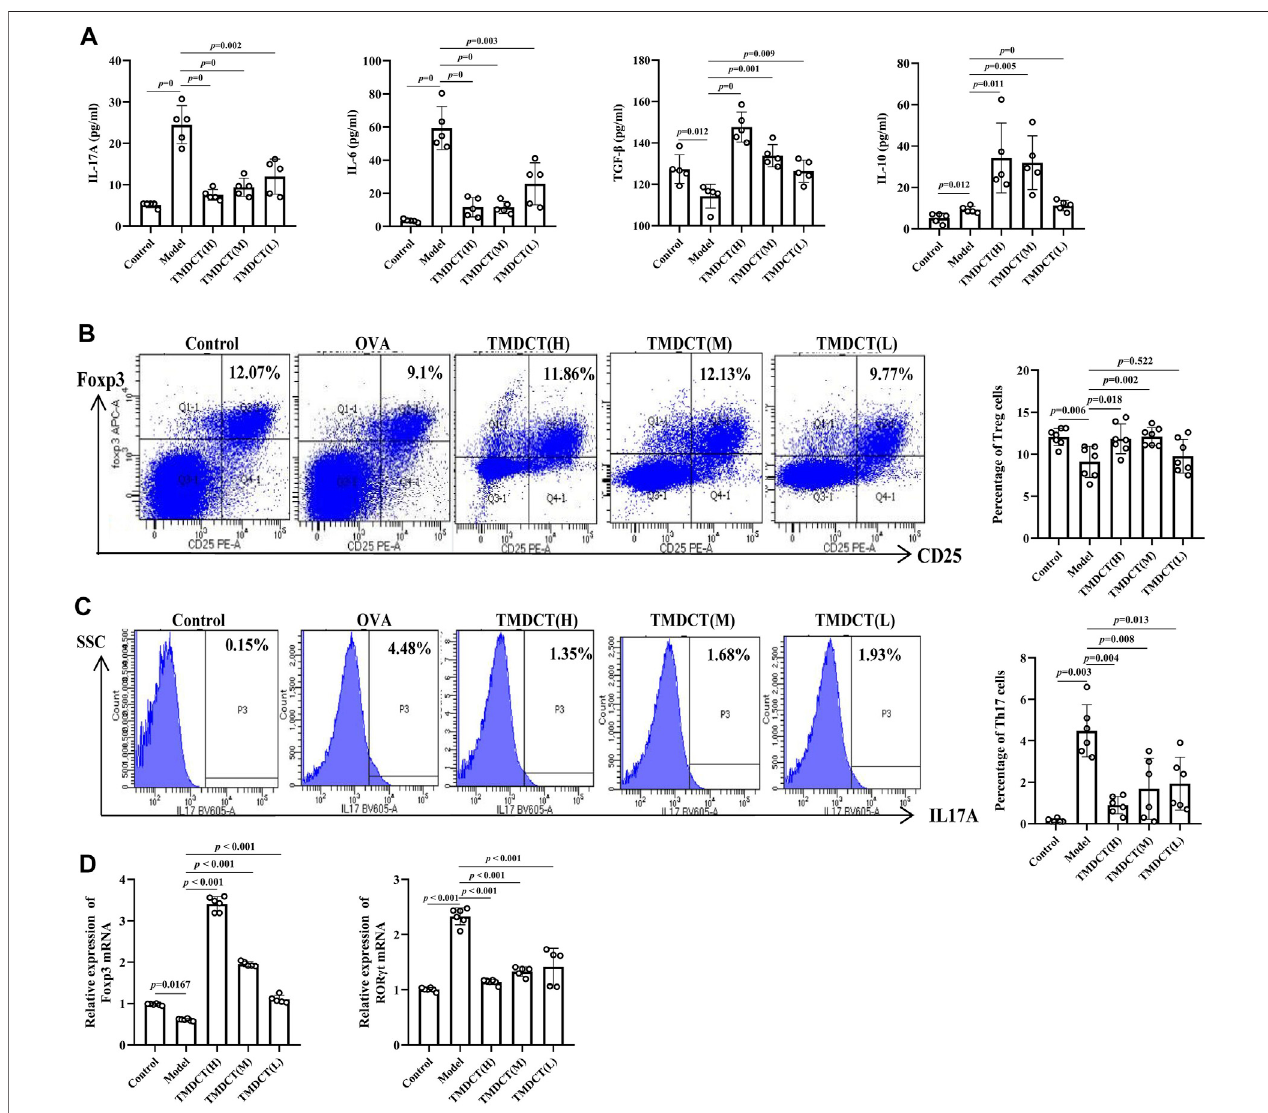
FIGURE2| TMDCTregulateTreg/Th17balanceineosinophilicasthmaBALB/cmice. (A) Detectionofcytokines(IL-17A,IL-6,TGF- β ,IL-10). (B,C) Left:intracellular staining FOXP3+ and IL-17 in CD4+ T cells in spleen tissue. Right: statistic data of FOXP3+, IL-17+ percentages. (D) Real-time PCR data of FOXP3 and ROR γ t mRNA expression in lung tisue. All the values are expressed as mean +/- SEM. n = 5-7 animals per group.